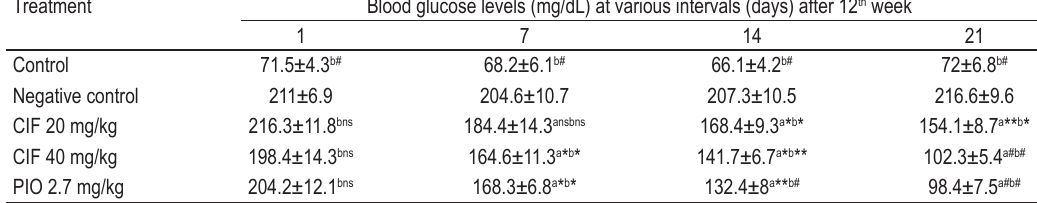
TABLE 2. Effect of CIF on blood glucose levels in post treated rats during 21 days of treatment from 12 th week after STZ administration Treatment Blood glucose levels (mg/dL) at various intervals (days) after 12 th